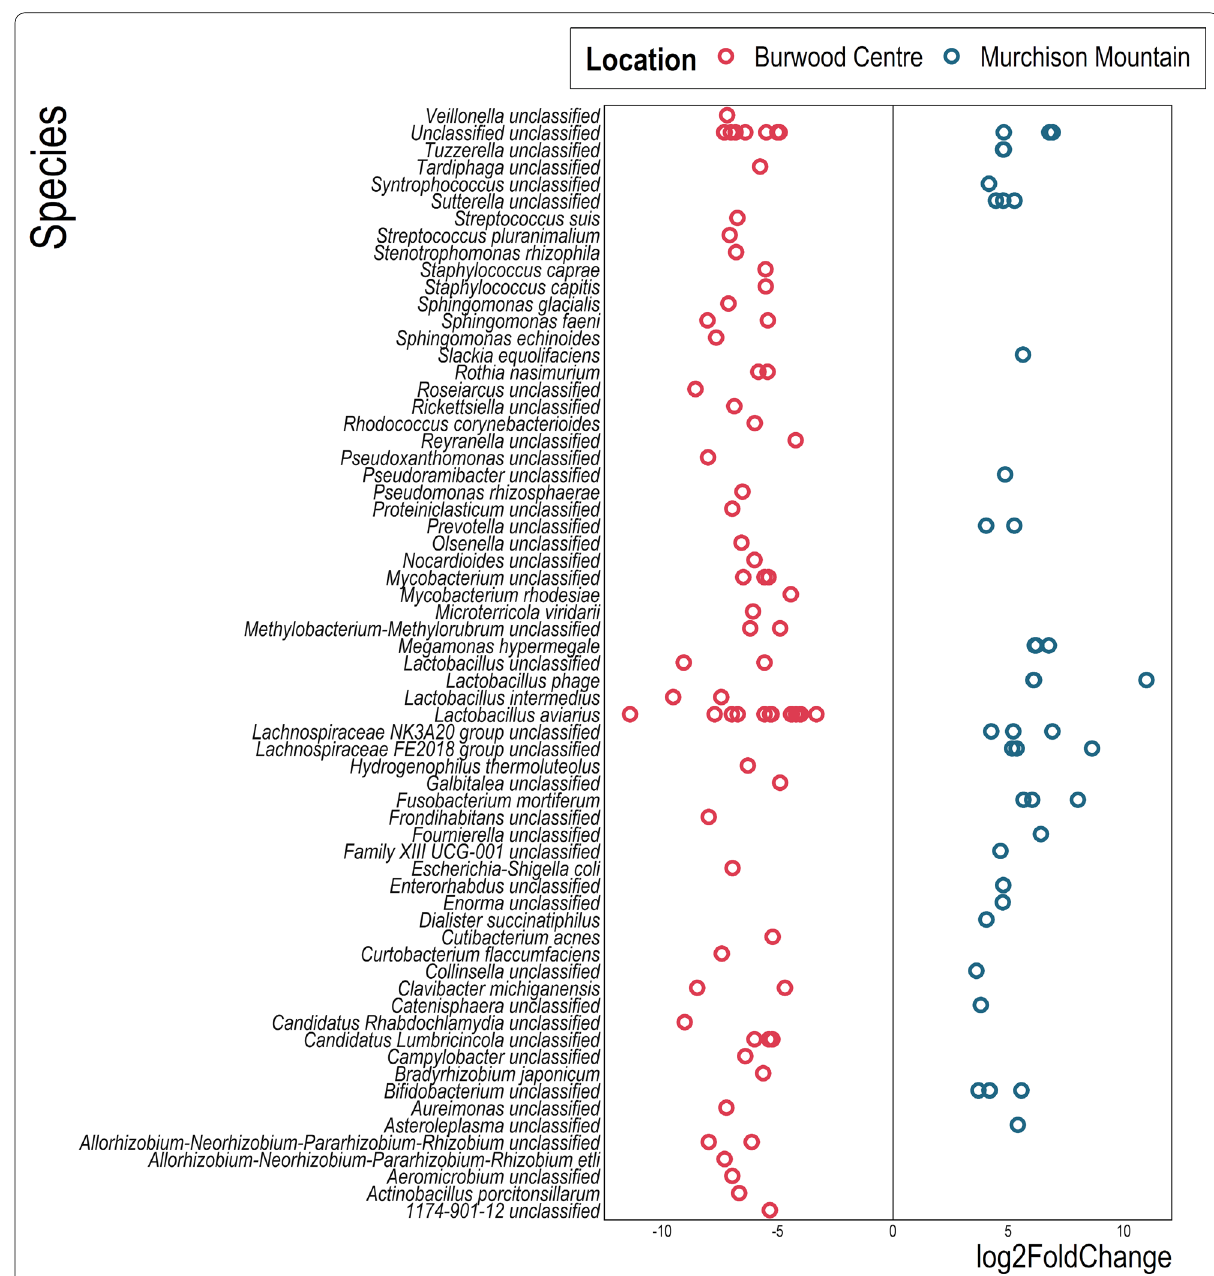
Fig. 4 Differentially abundant ASVs ( p value < 0.01; Wald test with local regression fit and Benjamini–Hochberg p value adjustment) between Burwood Takahē Centre and Murchison Mountain locations. Each circle represents an individual 16S rRNA gene defined